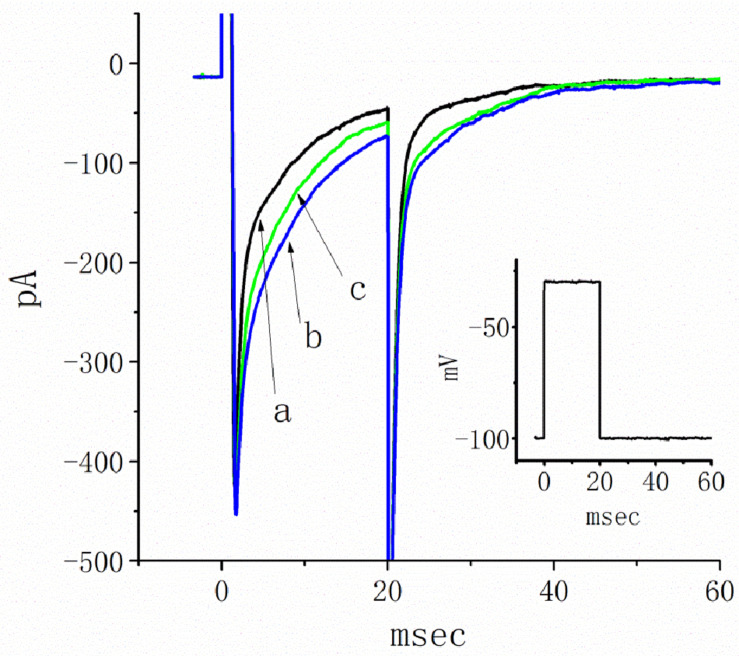
Inhibitory effects of telmisartan (TEL) on INa in HEK293T cells expressing SCN5A. In this set of recordings, cells were bathed in Ca2+-free Tyrode’s solution, and the recording pipette was filled with a Cs+-containing solution. The cells tested were rapidly depolarized from −100 to −30 mV for a duration of 20 ms (indicated in inset). Original current traces obtained in the absence (a) or presence of 3 μM TEL (b) and 3 μM TEL and 10 μM Ran (c).